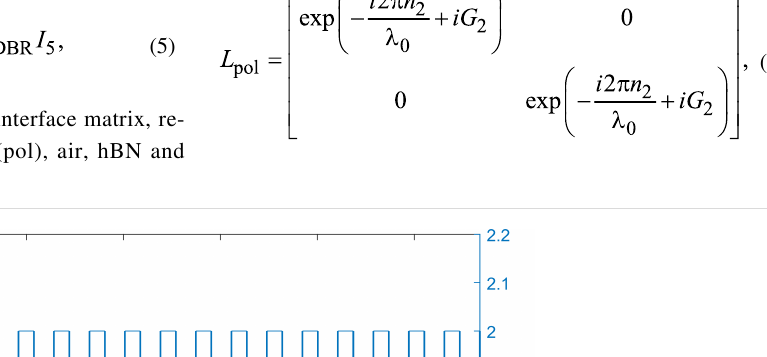
matrix model [24] was used to calculate the electric field distri- bution inside the hBN + DBR system (Figure